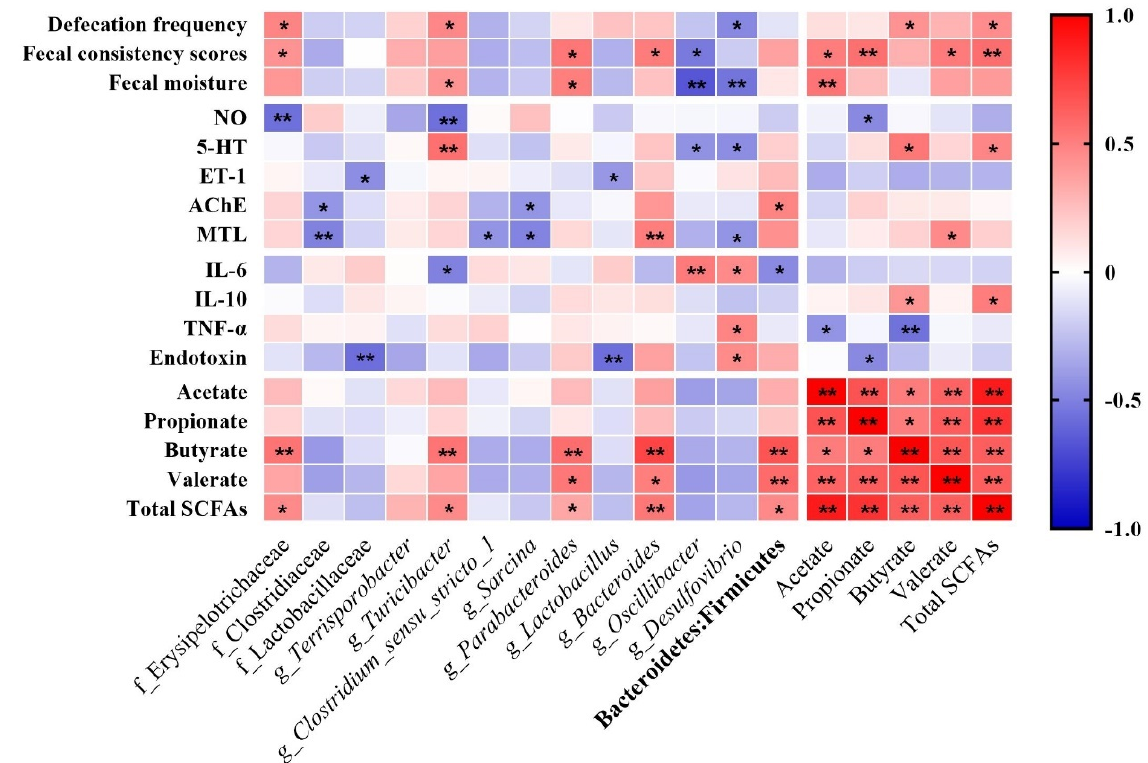
Figure 7. Correlation between fecal microbiota and defecation performances and serum parame- ters in Spearman correlation analysis. 5-HT, 5-hydroxytryptamine; NO, nitrogen monoxide; ET-1, endothelin-1; AChE, acetylcholinesterase; MTL, motilin; IL-6, interleukin-6; L-10, interleukin-10; TNF- α , tumor necrosis factor α . Red indicates a positive correlation; blue indicates a negative correlation. *, 0.01 < p ≤ 0.05; **, 0.001 < p ≤